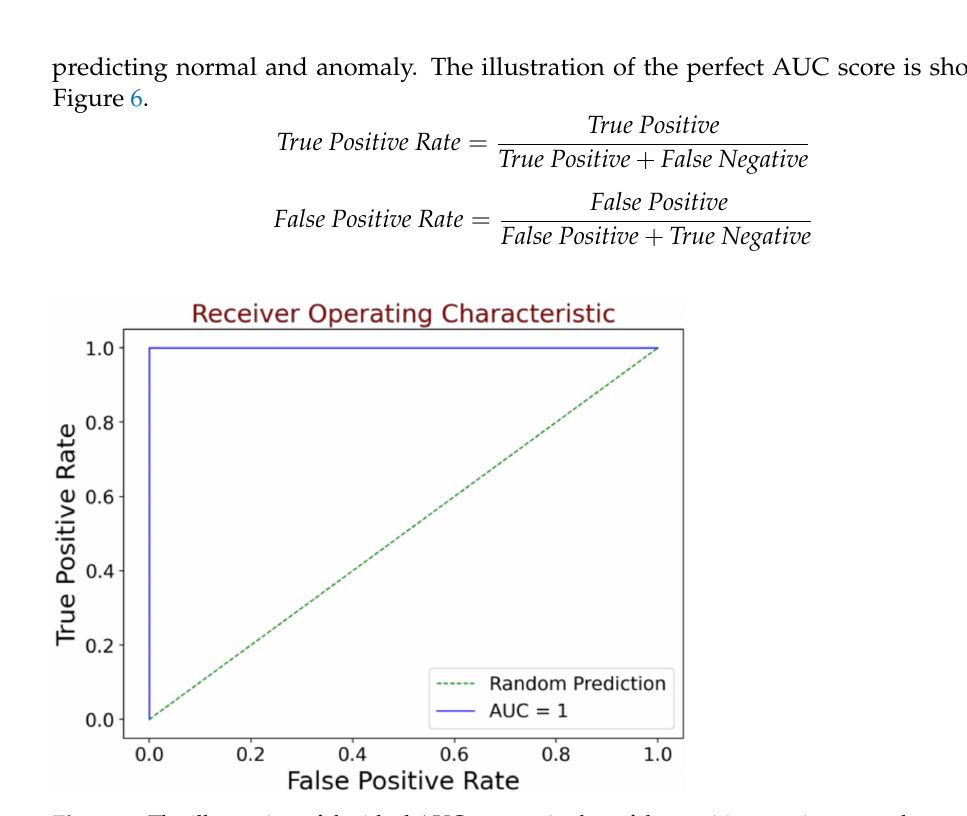
Figure 6. The illustration of the ideal AUC score = 1 where false positive rate is zero and true positive rate is one. This means that a larger area under the curve is better.